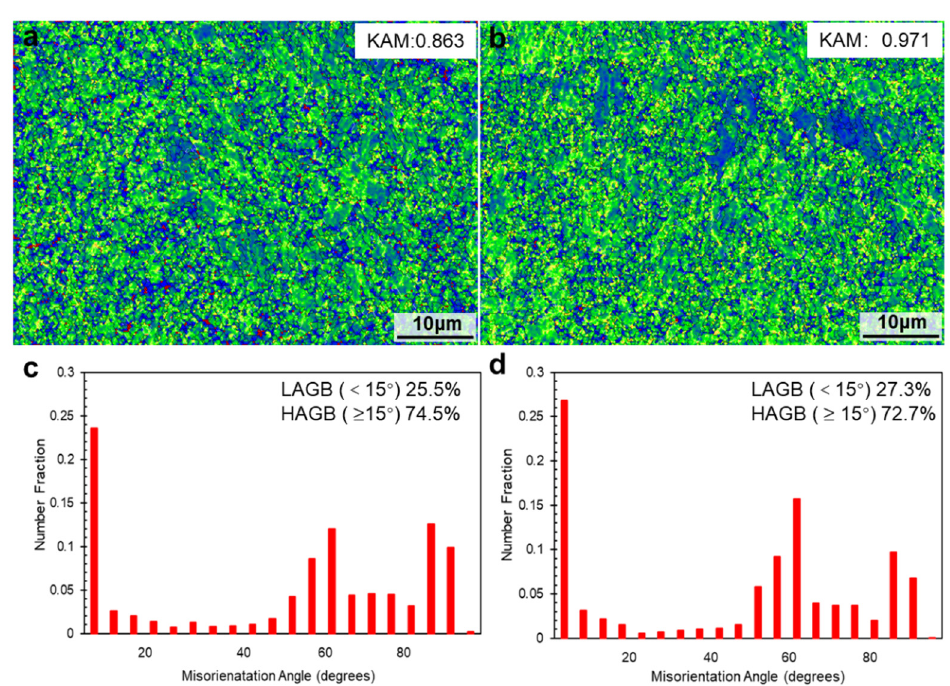
Figure 12. Kernel average misorientation (KAM) maps of the as-SLMed H13 specimens and misori- entation angle with low-angle grain boundaries (LAGBs) and high-angle grain boundaries (HAGBs): ( a , c ) horizontal direction; ( b , d ) building direction.